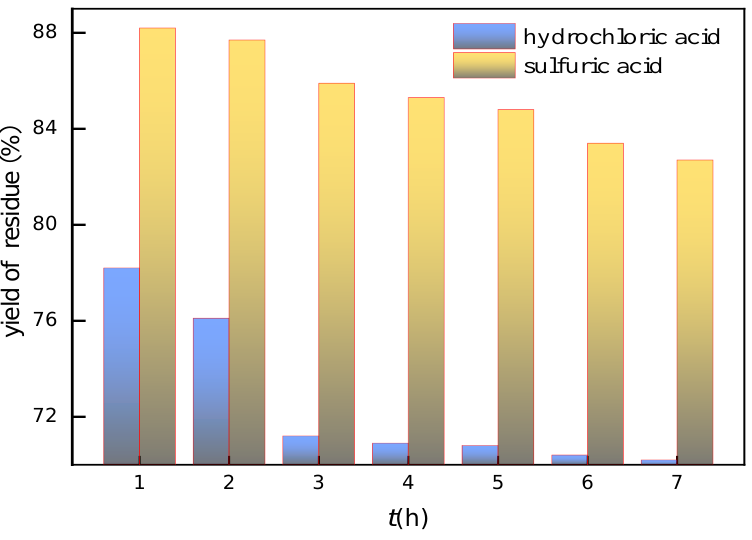
Figure 6. The effect of acid leaching time on the yield of residue.